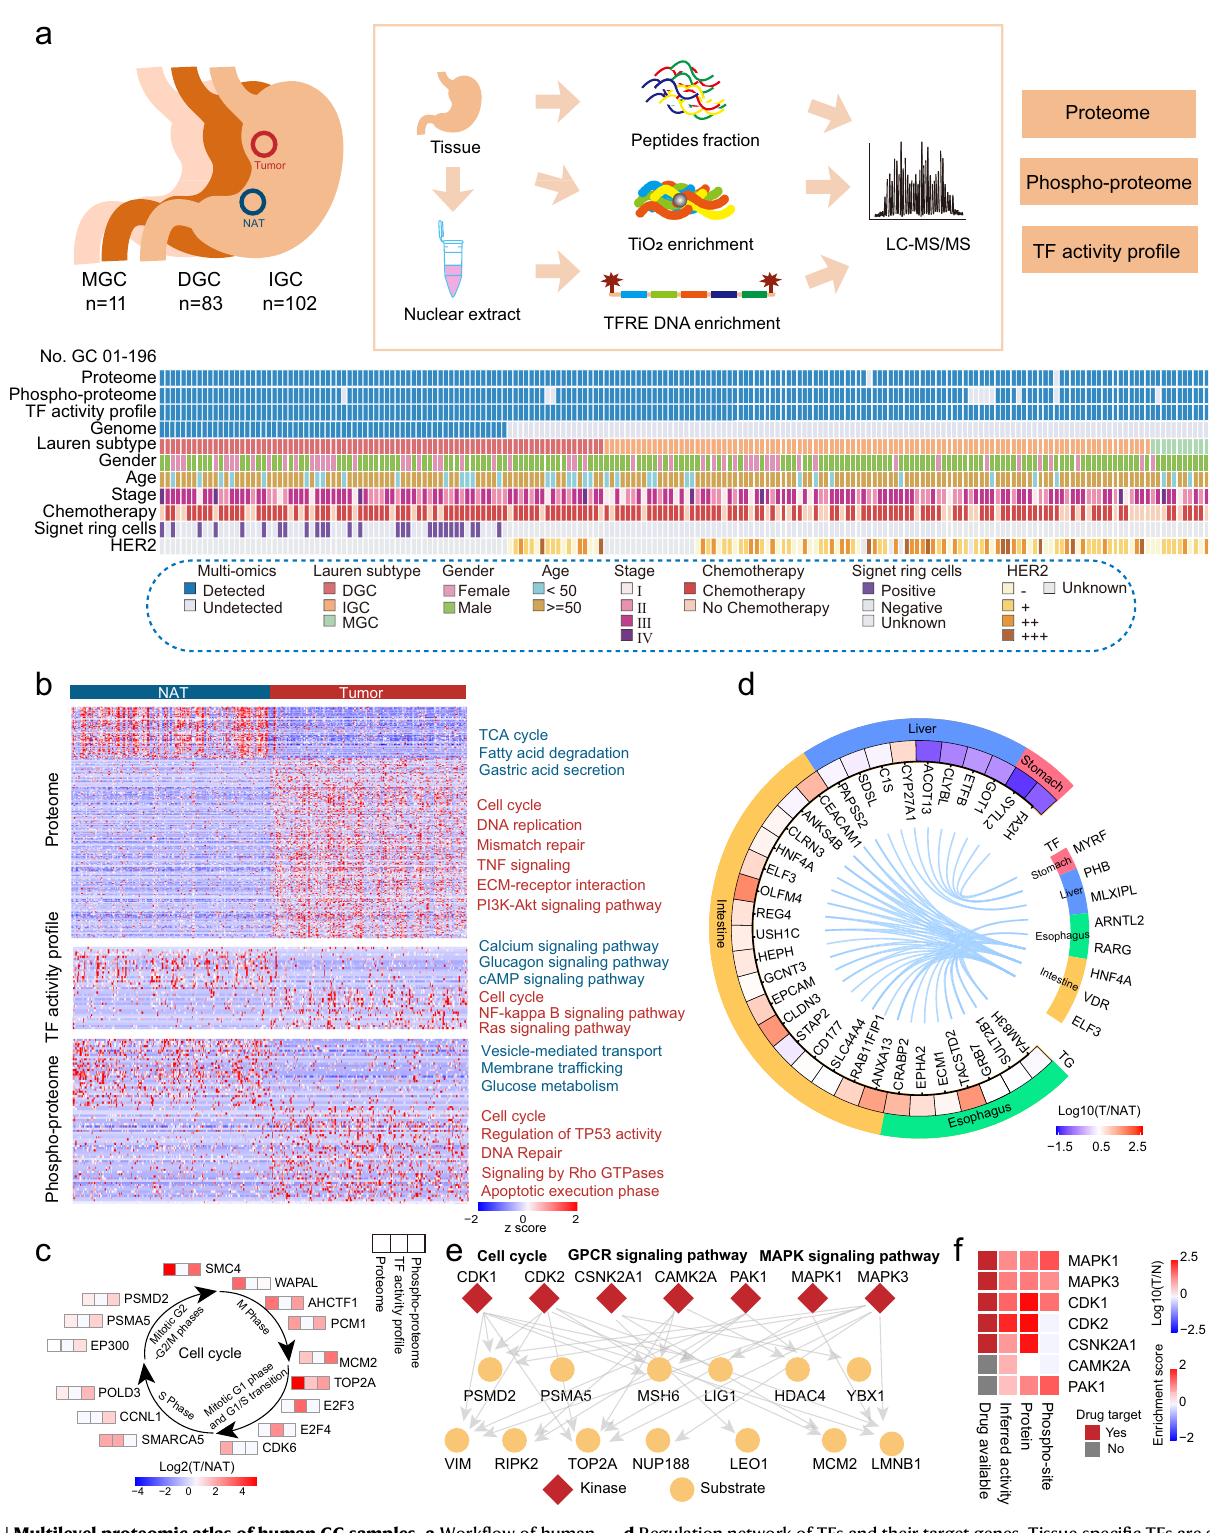
Fig. 1 | Multilevel proteomic atlas of human GC samples. a Work fl ow of human gastric cancer multilevel proteomic atlas construction. b Differentially expressed proteins in tumor tissues and NATs and their associated biological pathways. Red, upregulated pathways in tumor tissues; blue, upregulated pathways in NATs. c Representative differentially expressed proteins in the cell cycle with multilevel proteomic levels (proteome, TF activity pro fi le, and phospho-proteome).